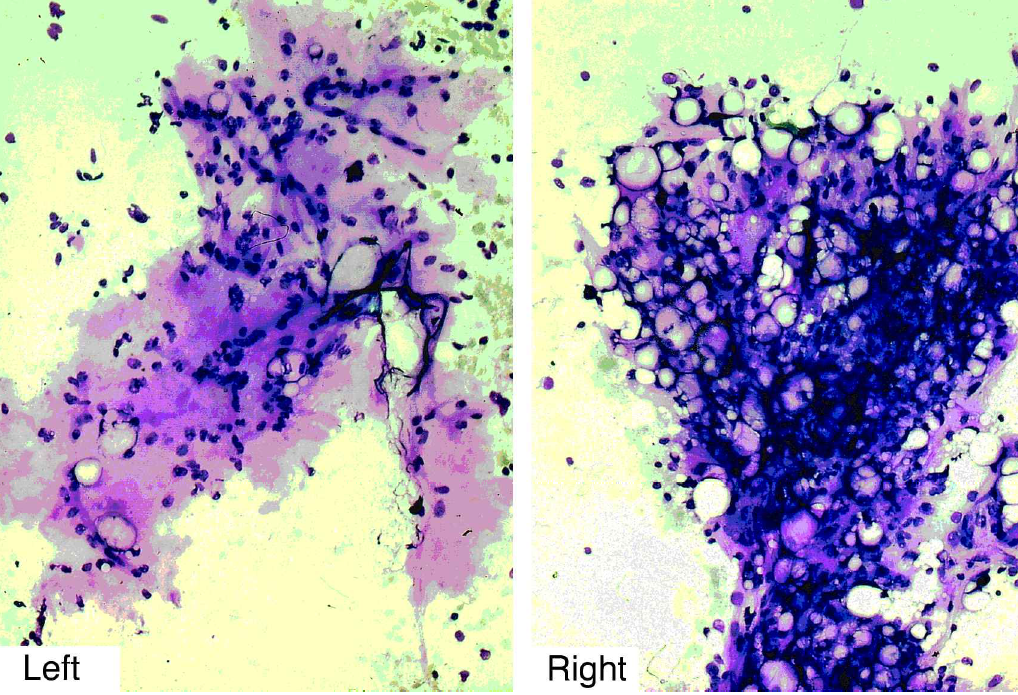
Fig. 1. Part of the smears from aspirates from two different areas of a large intramuscular sarcoma. Left: typical myxoid liposarcoma with myxoid background, branching capillaries and scattered lipoblasts. Right: Cellular tumour fragment with closely packed lipoblasts corresponding to round cell liposarcoma. (MMG 3 250).